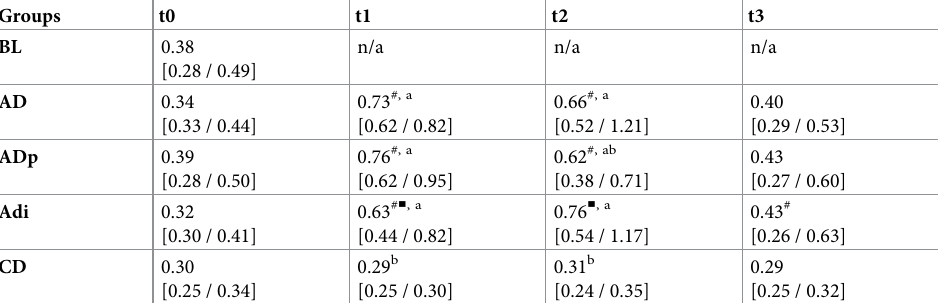
Table 5. a: Triglycerides concentrations in serum (mmol/L) of all groups at each sampling point (t0–t3). b: Bile acids concentrations in serum ( μ mol/L) of all groups at each sampling point (t0–t3). c: Hepatic triglyceride lipase con- centrations in serum (mmol/L) of all groups at each sampling point (t0–t3). d: Cholesterol concentrations in serum (mmol/L) of all groups at each sampling point (t0–t3). Groups t0 t1 t2 t3 BL 0.38 n/a n/a n/a [0.28 / 0.49] AD 0.34 0.73 #, a 0.66 #, a 0.40 [0.33 / 0.44] [0.62 / 0.82] [0.52 / 1.21] [0.29 / 0.53] ADp 0.39 0.76 #, a 0.62 #, ab 0.43 [0.28 / 0.50] [0.62 / 0.95] [0.38 / 0.71] [0.27 / 0.60] Adi 0.32 0.63 # ■ , a 0.76 ■ , a 0.43 # [0.30 / 0.41] [0.44 / 0.82] [0.54 / 1.17] [0.26 / 0.63] CD 0.30 0.29 b 0.31 b 0.29 [0.25 / 0.30] [0.24 / 0.35] [0.25 / 0.32] [0.25 / 0.34] Triglycerides concentrations are presented as medians and [25th / 75th] percentiles in mmol/L. # ■ Different symbols indicate significant differences within a row (time-point differences in a group). ab Lowercase letters indicate significant effects within a column (group differences at one timepoint). Significant differences are identified by P values � 0.05 using Kruskal–Wallis test with Bonferroni correction. BL, baseline group (n = 8); AD, group fed atherogenic diet (n = 10); ADp, group fed atherogenic diet + pectin (n = 10); ADi, group fed atherogenic diet + inulin (n = 10); CD, group fed conventional diet (n = 10); n/a, not available. https://doi.org/10.1371/journal.pone.0275214.t005 plaques (10/10 animals affected) than in the AD group (5/10 animals affected, Table 6 ). Plaque sizes did not differ significantly between the groups (P = 0.33, Kruskal-Wallis test with Bonfer- roni correction). Additionally, no association was found between the plaque frequency per group and plaque size. The smallest plaque was observed in the baseline group. Original data of plaque formation are provided in a supplementary table ( S4 Table) .